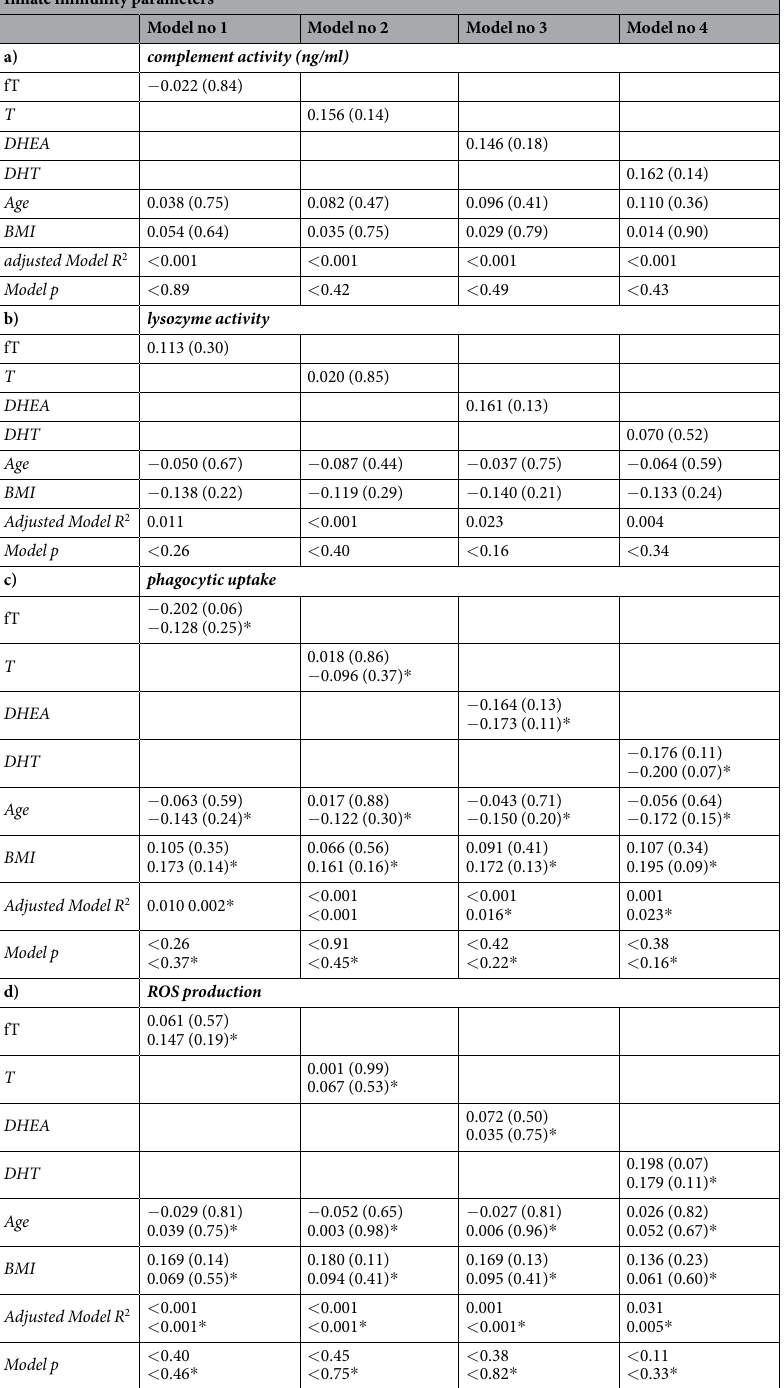
Table 3. Multiple regression models showing the relationship between each androgen and innate immune parameters (a–d), when participants’ age and body mass index (BMI) were controlled. * Standardized beta coefficients with p values in parentheses for analyses without statistical outliers for immune factors (N = 93 for phagocytic uptake, and N = 94 for reactive oxygen species [ROS] production). Entries are standardized beta coefficients with p values in